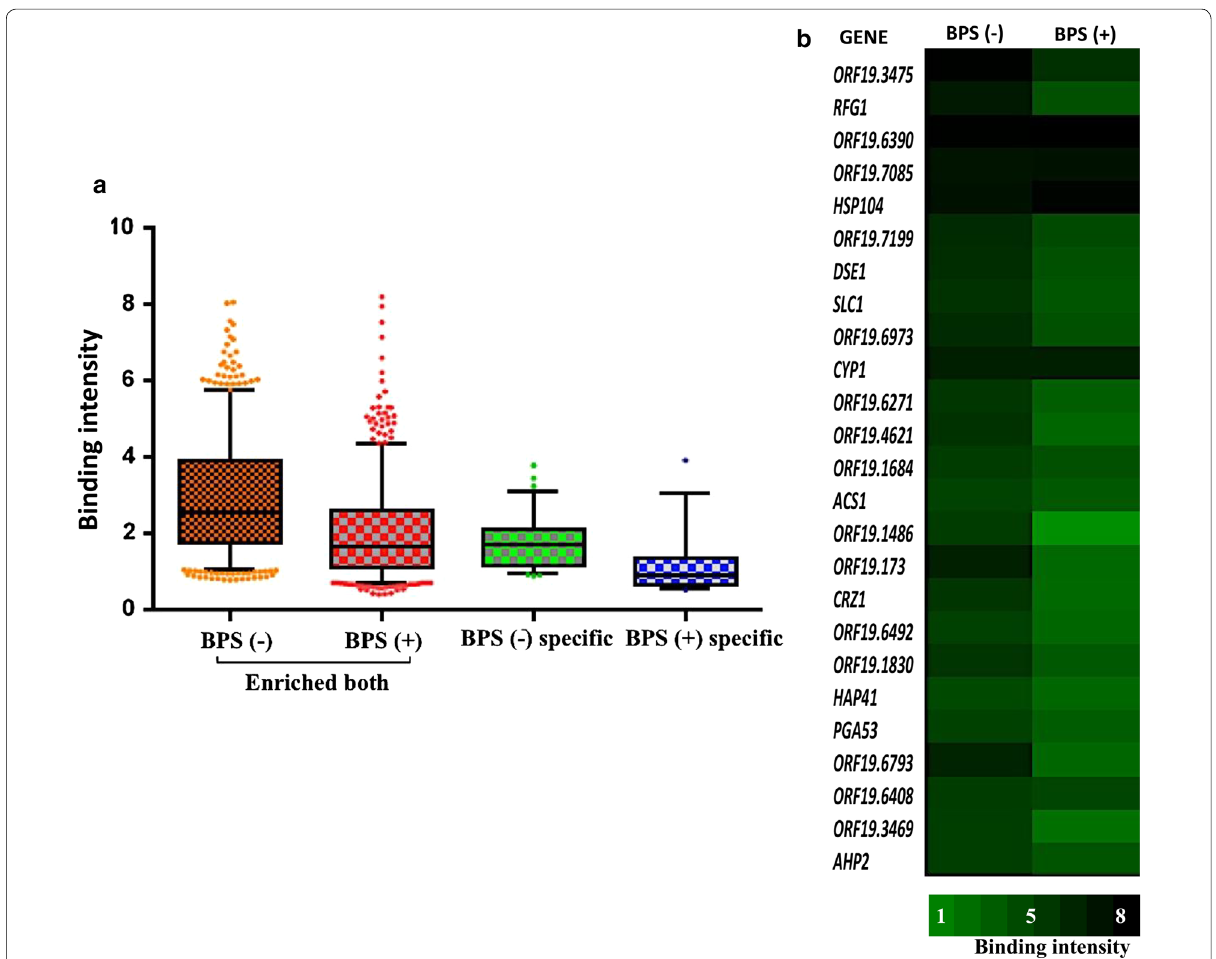
Fig. 6 Binding intensities of Hsf1— a the distribution of binding intensity are represented by box and whisker plots for all the three categories— enriched both, BPS ( ) specific and BPS ( ) specific. b Top 25 genes which show strongest binding intensities under normal conditions are − + represented here. Their binding intensities as compared to iron deprived conditions are depicted